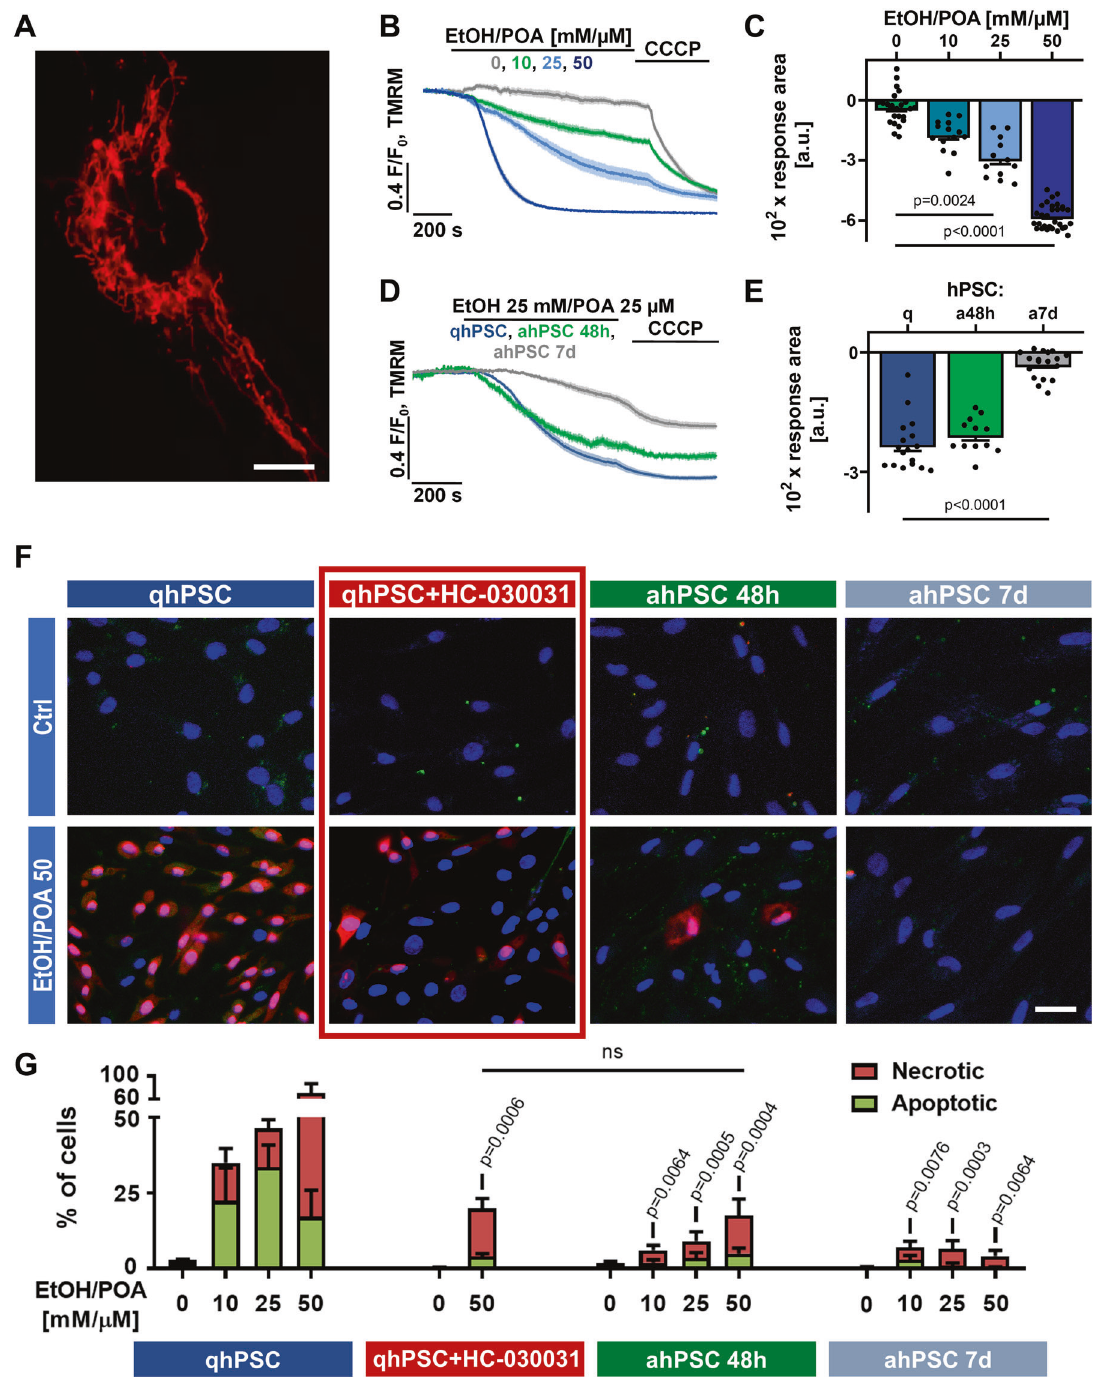
Fig. 6 Activated hPSCs are resistant to EtOH/POA-induced loss of mitochondrial potential ( Δψ ) as well as cell death. A Image shows mitochondrial localisation of TMRM in hPSCs. Scale bar: 10 μ m. B The average traces (±SEM) show a decrease in TMRM fl uorescence recorded in hPSCs in response to different concentrations of EtOH/POA: 0 (Ctrl, n = 24, N = 3), 10 ( n = 14, N = 3), 25 ( n = 12, N = 3) and 50 ( n = 30, N = 3) mM/µM, respectively. CCCP (1 μ M) was applied at the end of each experiment to attain the maximal decrease of Δψ . C The bar graph shows the average decrease (±SEM) below the baseline levels calculated between 200 and 800s for the traces averaged in B. D Average traces (±SEM) show a decrease in TMRM fl uorescence recorded in response to 25mM EtOH and 25µM POA in quiescent hPSCs (blue; n = 16, N = 3), TGF- β -activated PSCs for 48h (green; n = 11, N = 3) and TGF- β -activated PSCs for 7 days (grey; n = 17, N = 3). CCCP (1 and 10 μ M) was applied at the end of each experiment to attain the maximal decrease of Δψ . E The bar graph shows the average decrease (±SEM) below the baseline levels calculated between 200 and 800s for the traces averaged in D. F Representative images of the staining of hPSCs with annexin V-FITC and propidium iodide after 30min incubation with 50mM EtOH and 50µM POA: quiescent hPSCs ( fi rst column), quiescent hPSCs incubated with TRPA1 inhibitor HC-030031 (second column), TGF- β -activated hPSCs for 48h (third column) and TGF- β -activated PSCs for 7 days (fourth column). Scale bar: 10 μ m. G The bar charts show the proportion of apoptotic (green) and necrotic (red) cells ±SEM (for all groups N = 3) calculated from the staining presented in F . Statistical signi fi cance was calculated for the combined dead cells (apoptotic + necrotic) for a given concentration of EtOH/POA between qhPSC vs qhPSC + HC-030031, ahPSC 48h and ahPSC 7 days, using one-way ANOVA followed by a post hoc analysis with the Dunnett ’ s T3 test. The signi fi cance between qhPSC + HC- 030031 and ahPSC 48h was calculated using the t